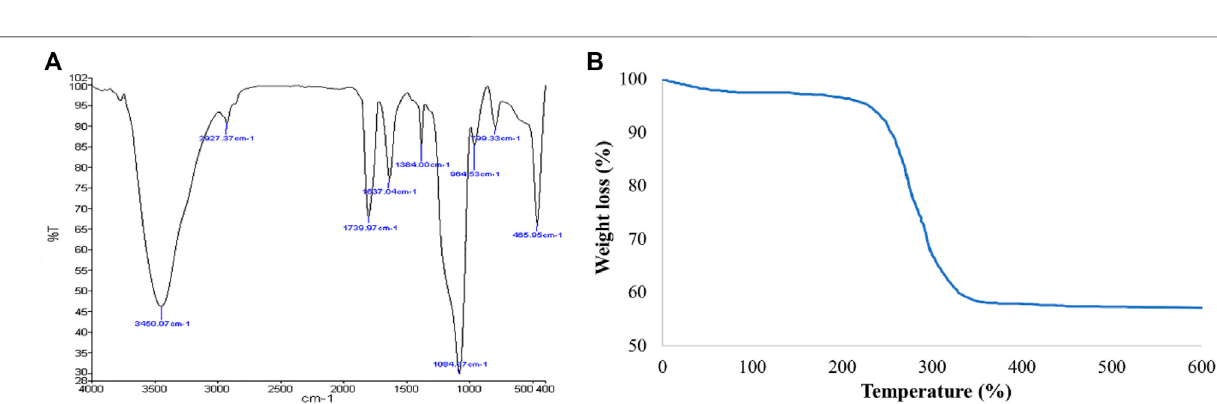
Frontiers in Chemistry |